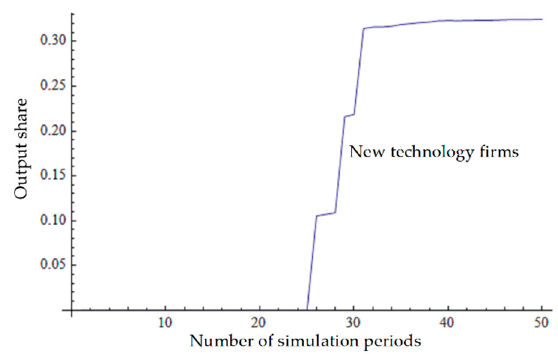
Figure 4. Transformation of the firm’s production technology.